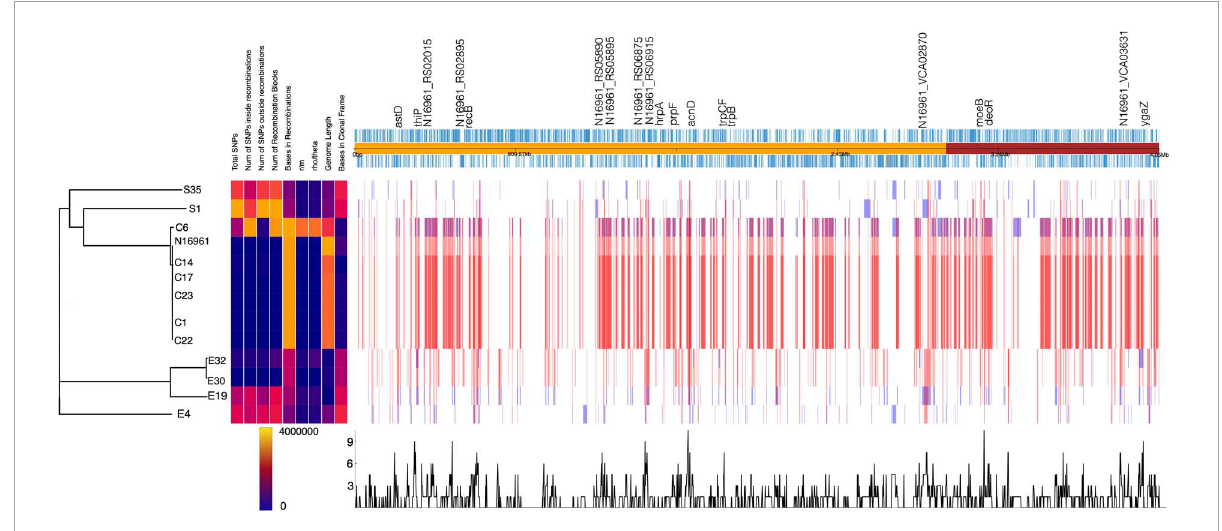
FIGURE4 Homologous recombination events detected in V. cholerae strains. The phylogenetic tree is generated from the number of SNPs. The homologous recombination events are shown by blocks, which are colored blue for unique events in strains and red for events occurring in multiple strains. The recombination hotspots are marked at the top of the